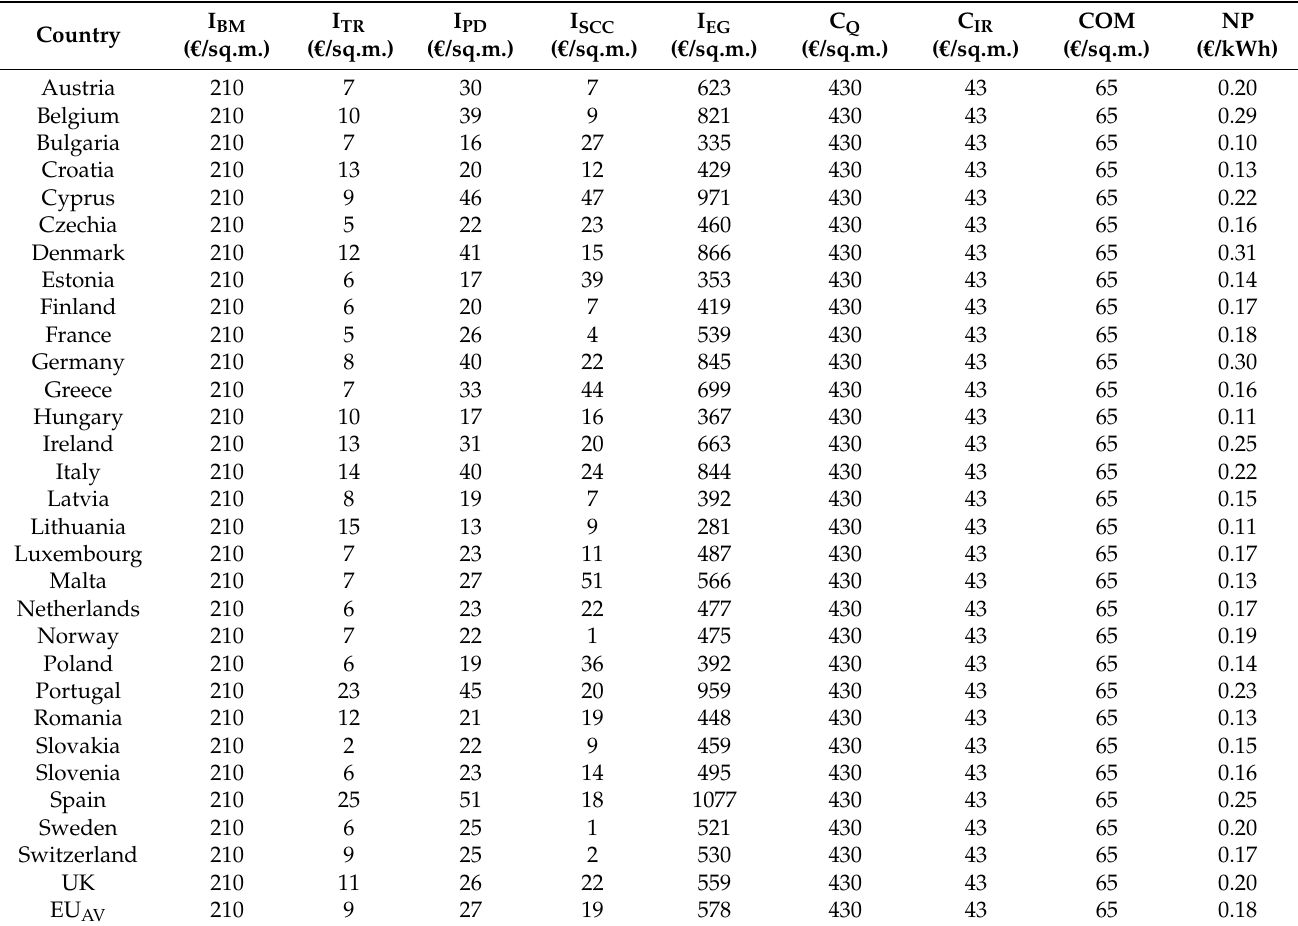
Table 2. System financial analysis in